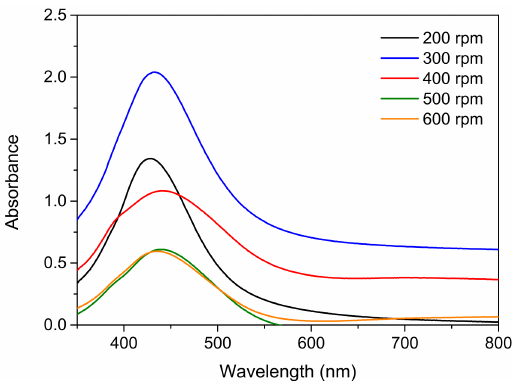
Figure 6. UV-Vis analysis results obtained for samples prepared at various rotation speeds.